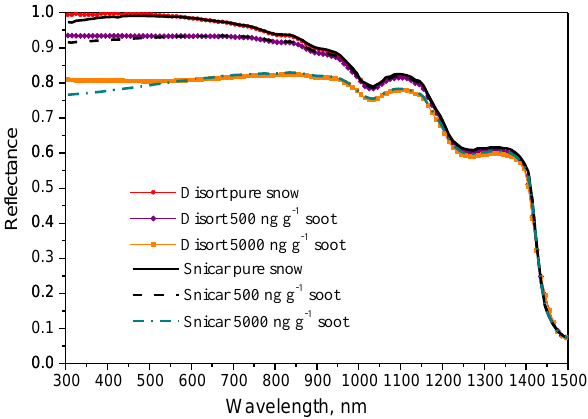
Fig. 10. Effect of BC on the snow reflectance for 500 and 5000 ng.g -1 of soot included as: layered on top, layered at 5 cm depth and mixed.